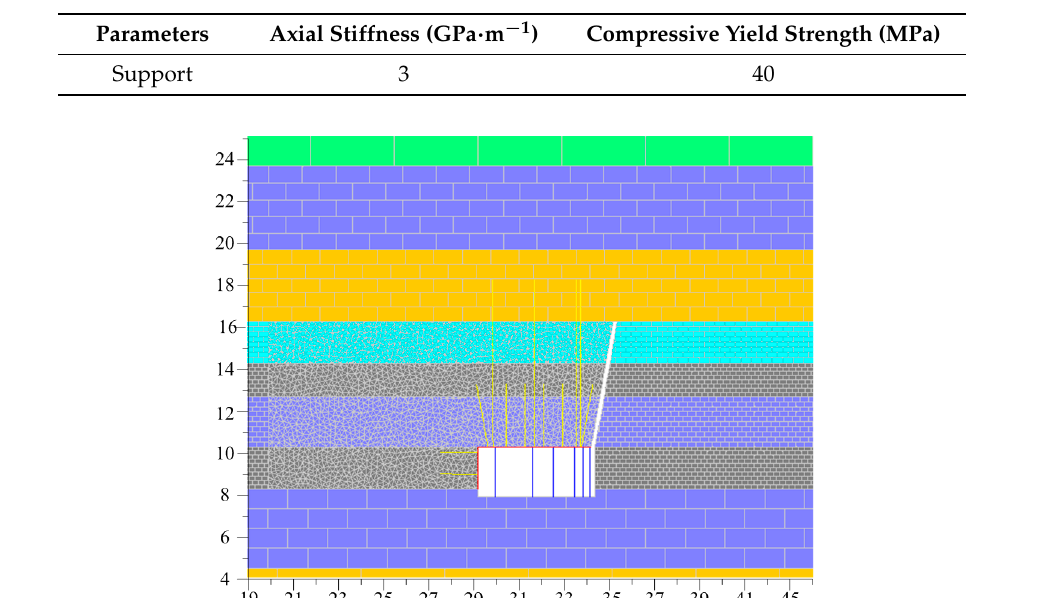
Table 5. Properties of the structure element in the UDEC.